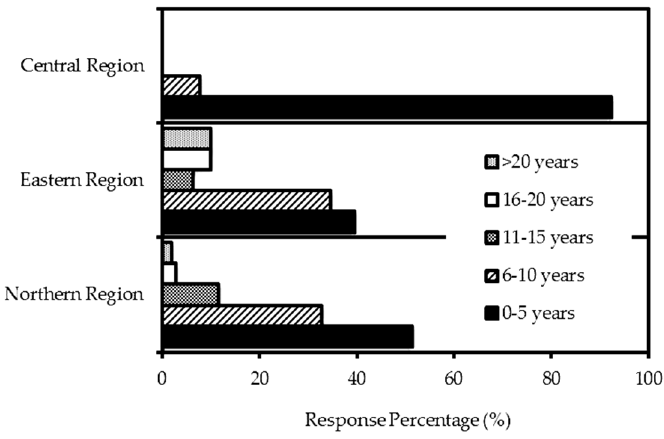
Figure 2. Years of experience of the respondents in rice farming. The total number of respondents for the northern, eastern and central regions was 113, 81 and 26, respectively.